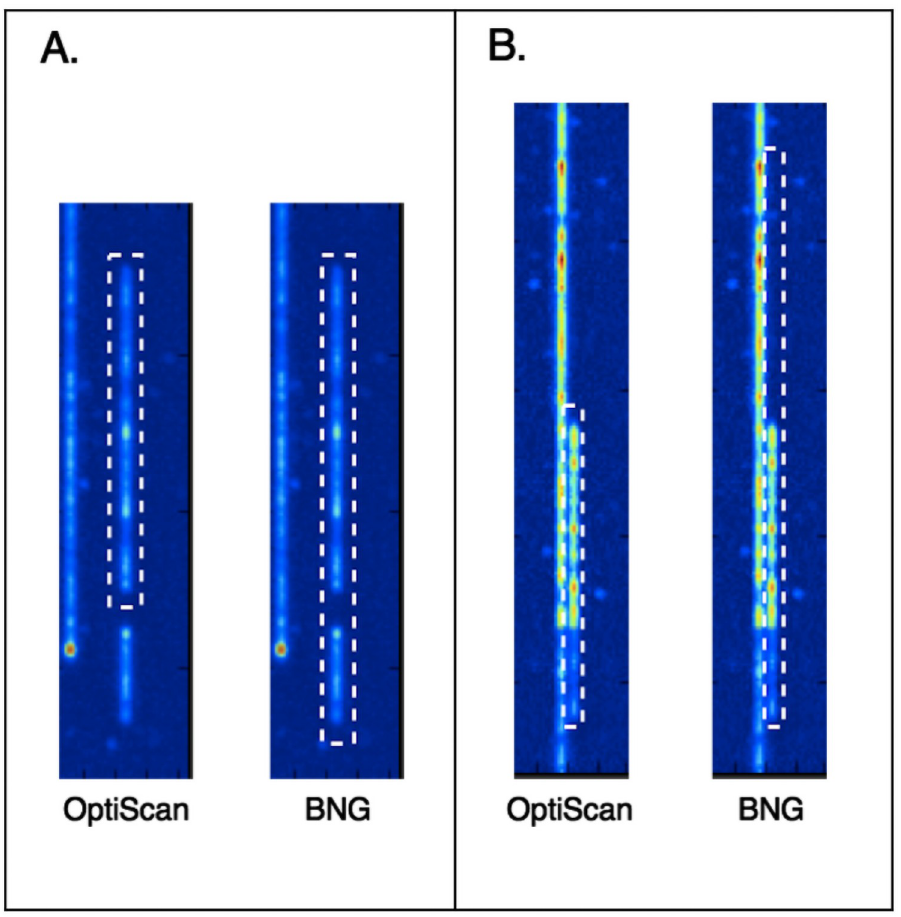
Fig 6. Molecule detection (yeast) by OptiScan and BNG. Two examples of cases where OptiScan errs on the side of caution in molecule detection. In both, the BNG molecule detection routine seems to generate erroneous